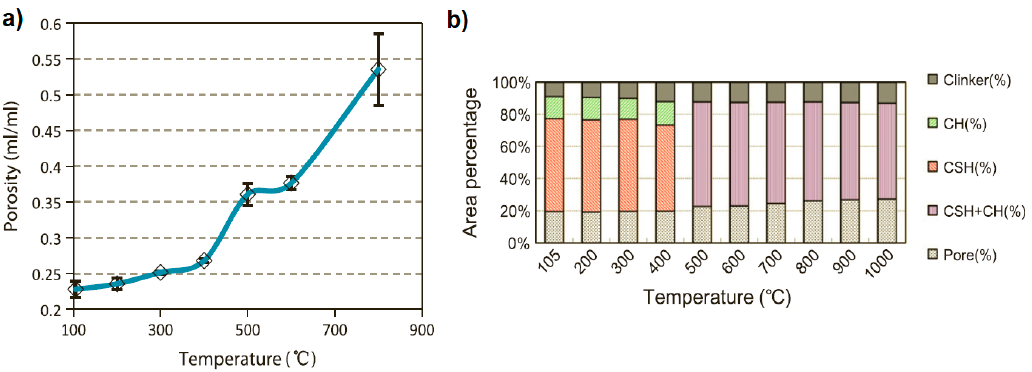
Figure 1. The effect of temperature on the change of total porosity ( a ) and the area percentage of each phase ( b ) of heated Portland cement paste after cooling. Reproduced with permission from [15].